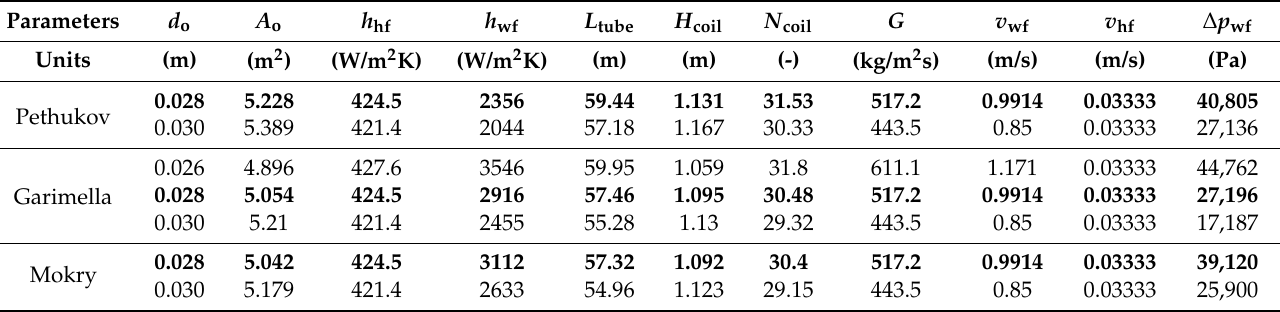
Table 5. Computational results for the helical coil heat